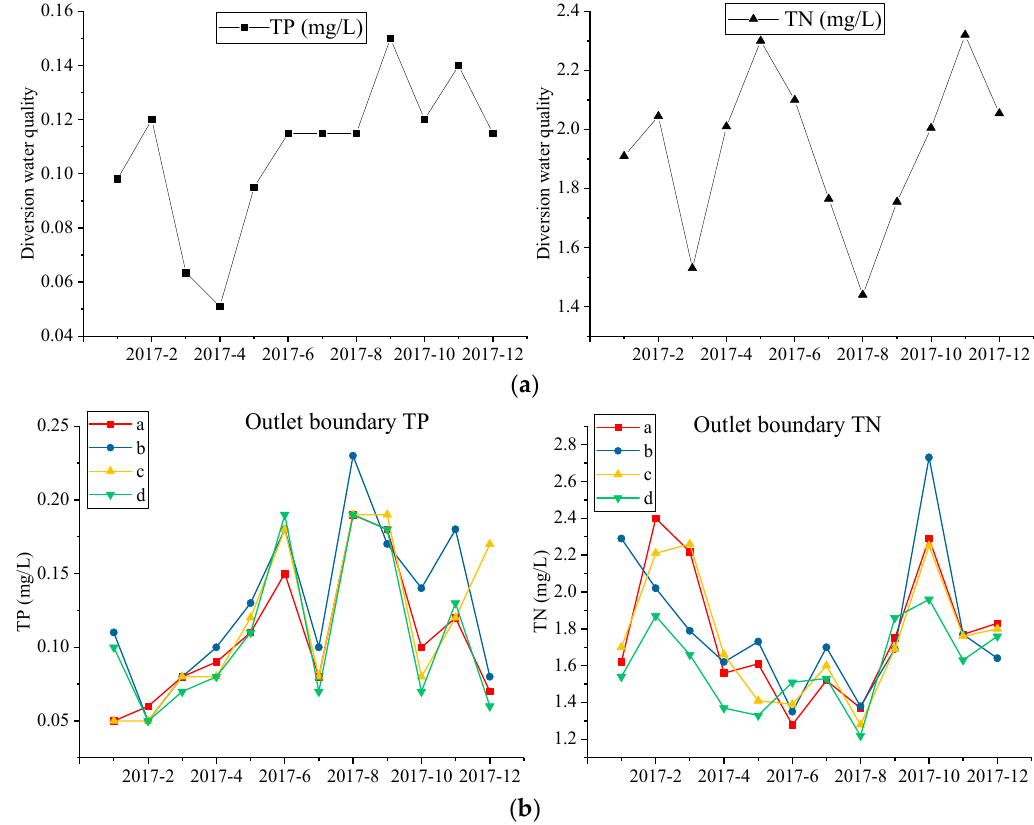
Figure 5. ( a ) Diversion water quality of Xuanwu Lake in 2017; ( b ) Outlet boundary water quality of Xuanwu Lake in 2017.